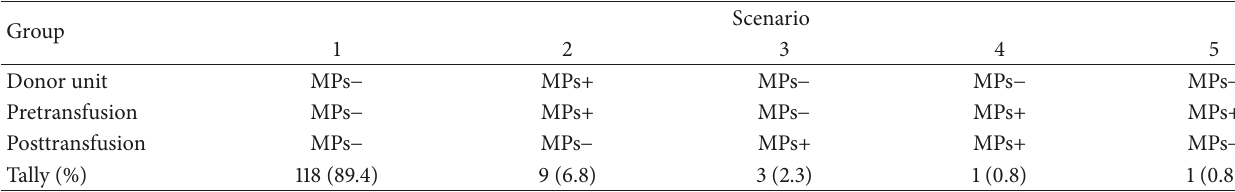
Table 1: Scenarios of the distribution of donor-recipient malaria parasitaemia among children receiving blood transfusion at ABUTH, Zaria ( 𝑛 = 132 ).